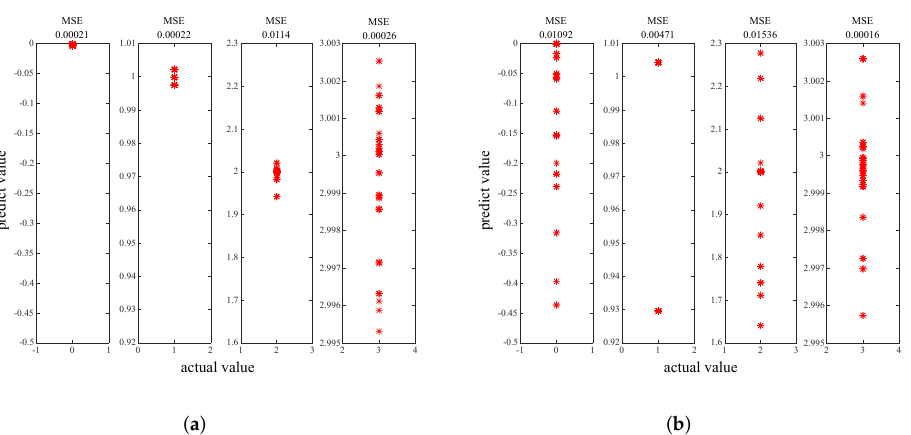
Figure 10. ( a ) Distribution of results using the method proposed; ( b ) distribution of results using the contrast method.